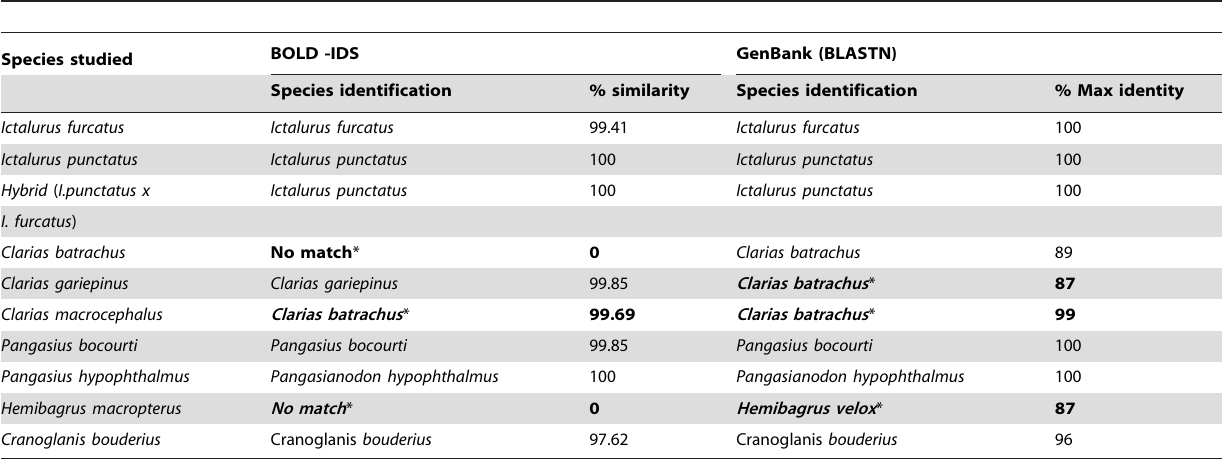
Table 2. Summary of identification based on each species consensus barcoded sequence using BOLD Identification System (BOLD-IDS) and BLASTN search from GenBank.